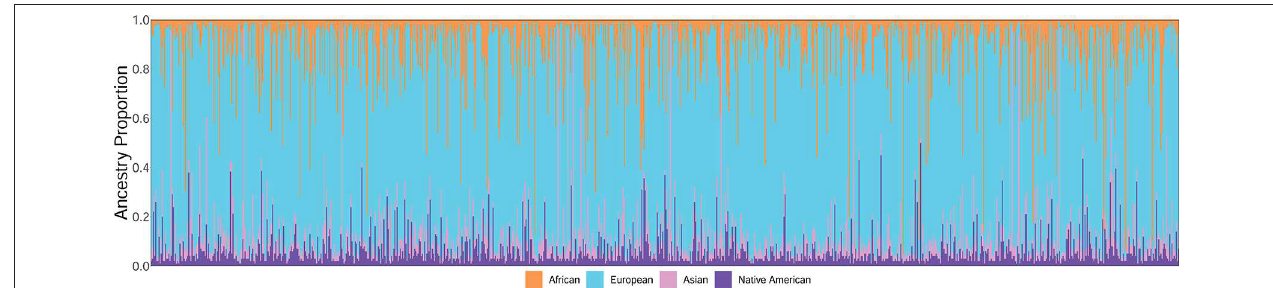
FIGURE 1 | Individual ancestry estimates for the Brazilian colorectal cancer patients ( n =